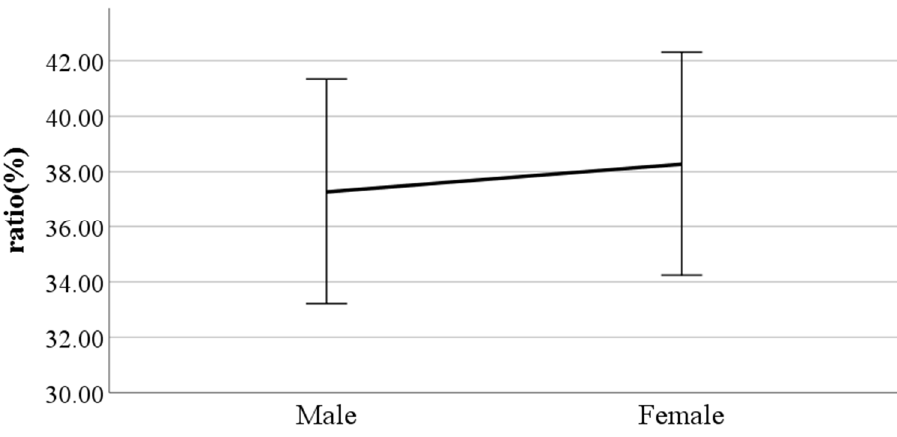
Figure 8. Gender difference in walking speed (F value: 3.58, DF: 289, p -value: 0.00).